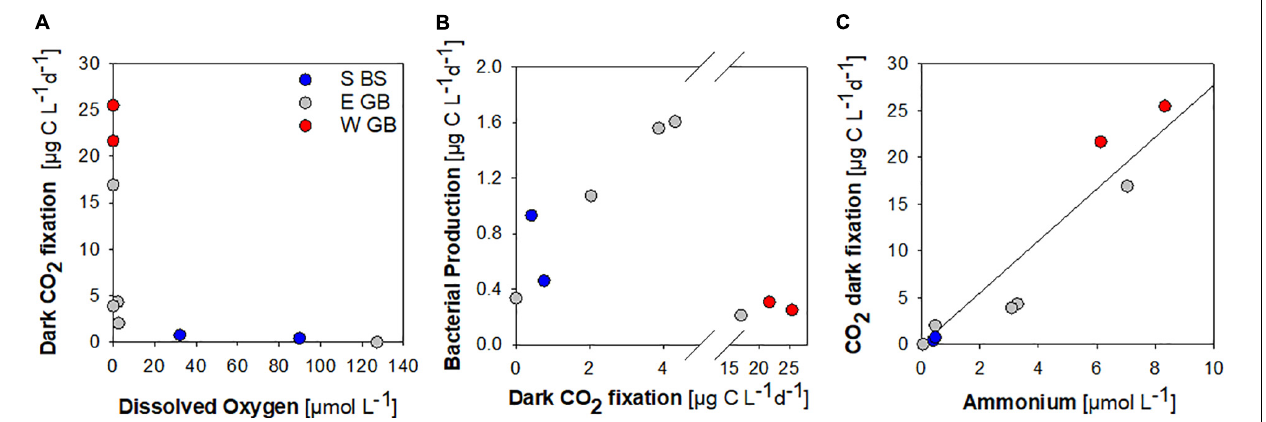
FIGURE 6 | Dark CO 2 fixation in the southern Baltic Sea (S BS), in the Eastern (E GB) and Western (W GB) Gotland Basin shown in relation to dissolved oxygen (A) , bacterial production (B) and ammonium ( r 2 = 0.91, p < 0.0001) (C)